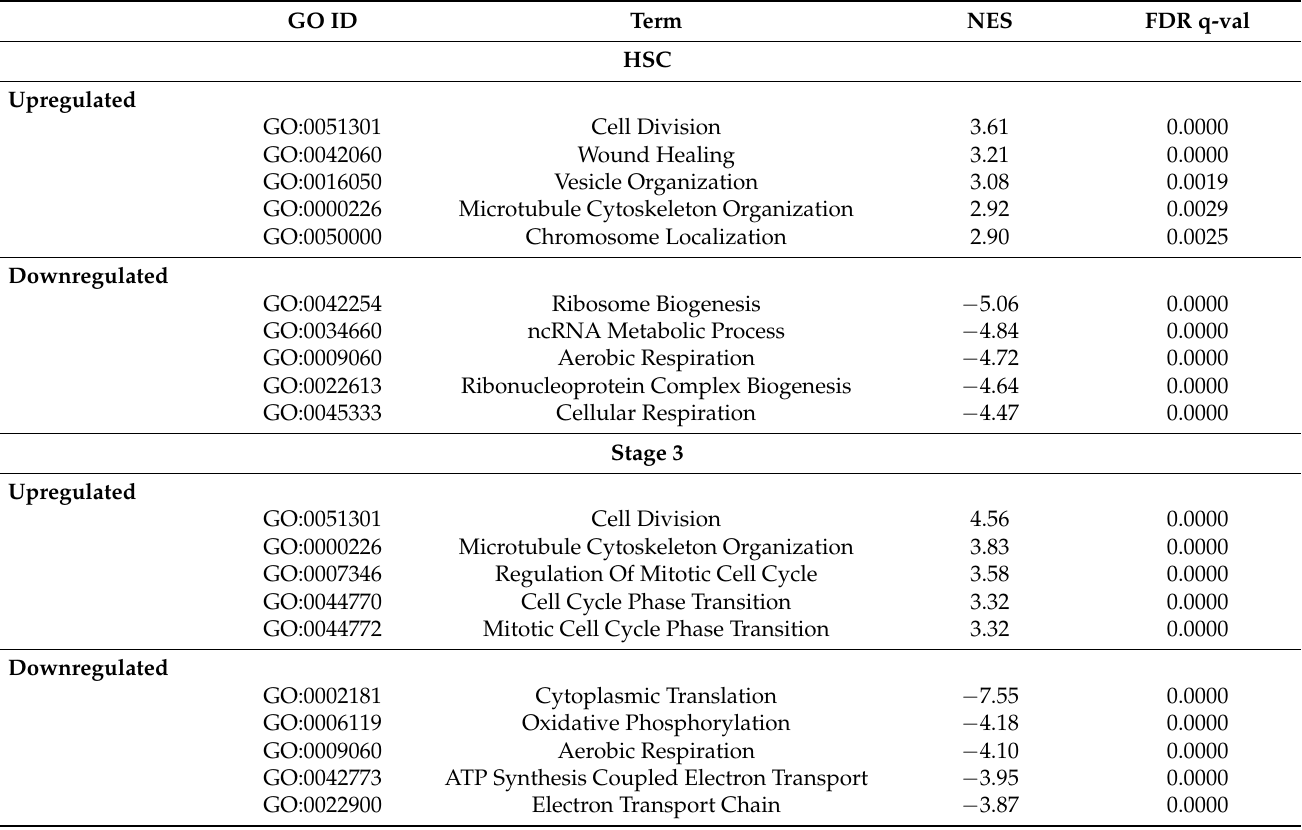
Table 1. The top five enriched biological processes in up- and downregulated differentially ex- pressed